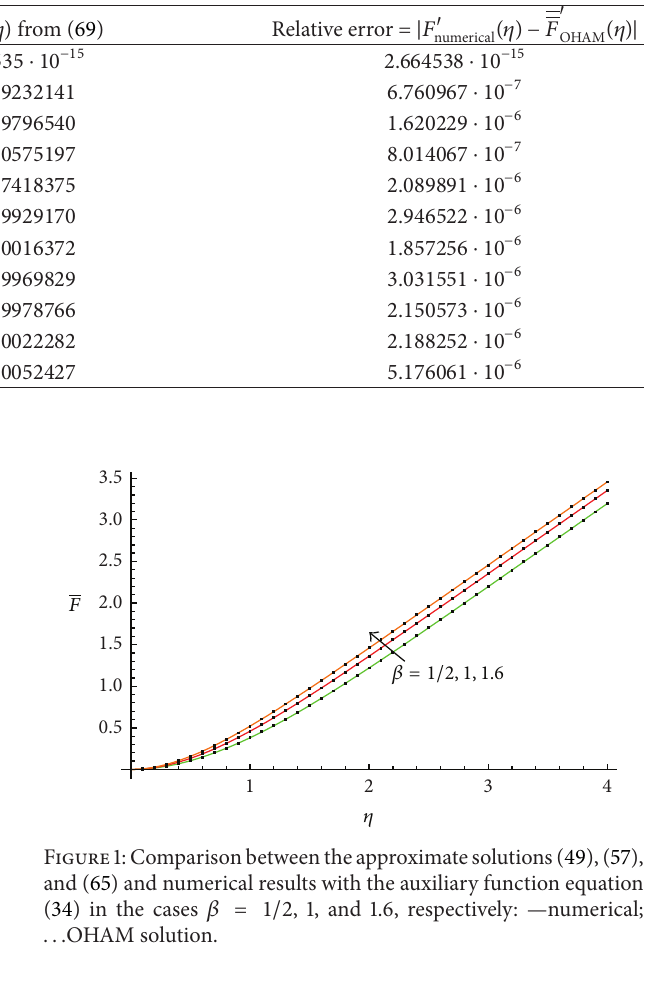
󸀠 (𝜂) obtained from (69) and numerical results for 𝛽 = 1.6 .